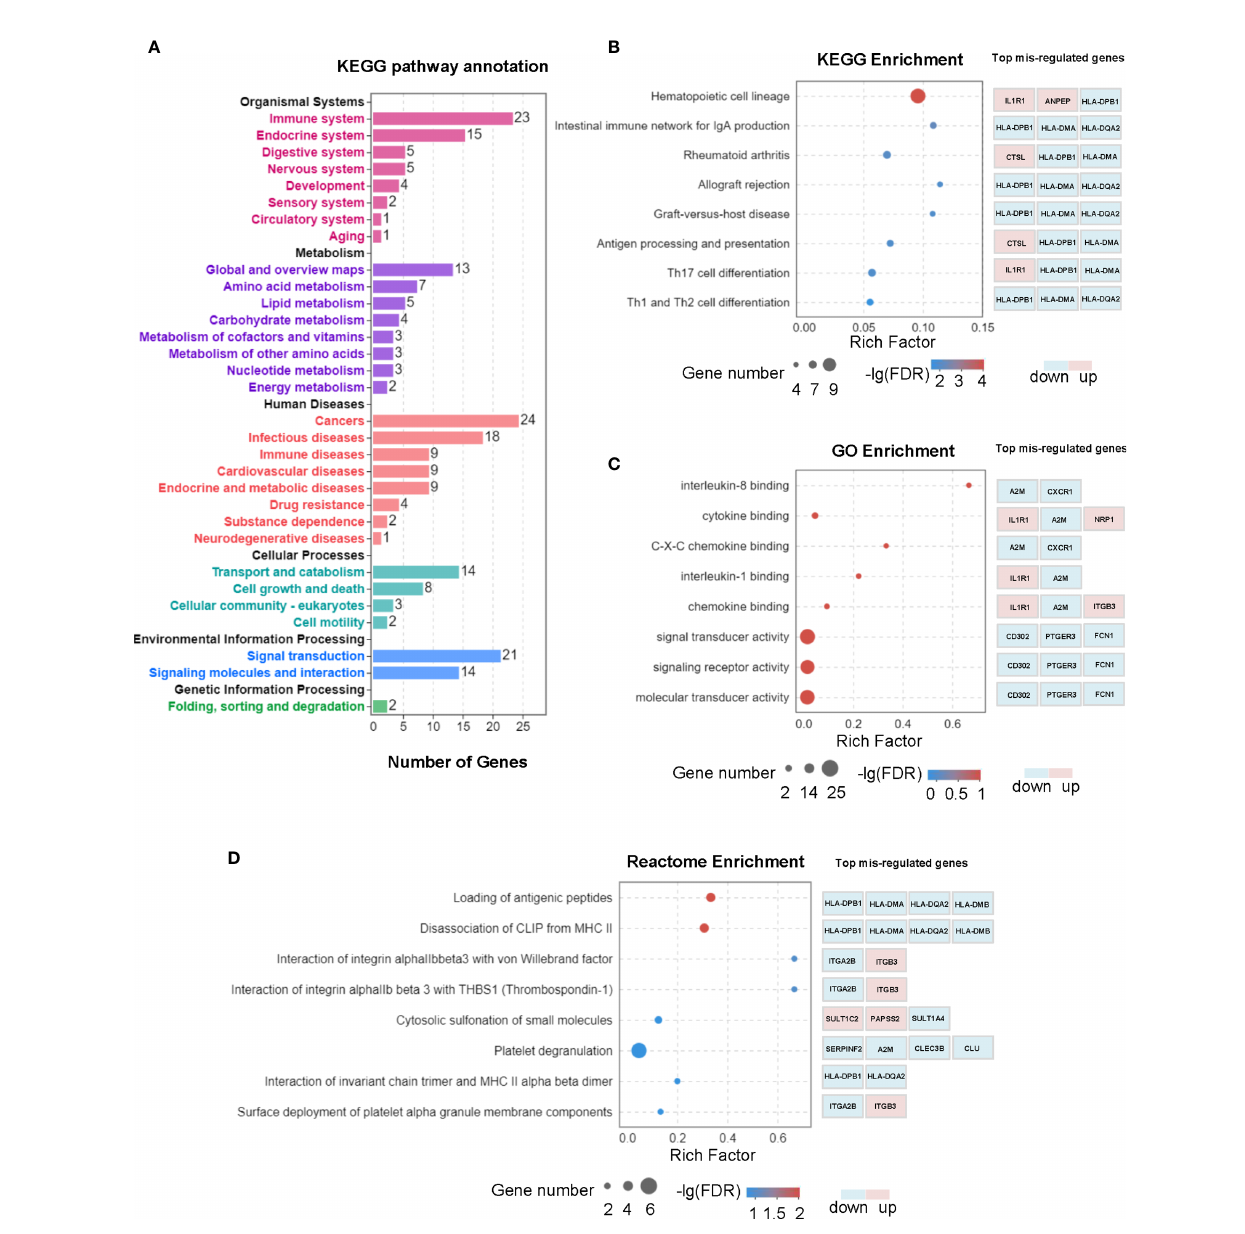
FIGURE 2 | Transcriptomic analysis revealed multiple changes in PBMCs after L-Cn stimulation. (A) KEGG analysis of genes enriched based on 168 differentially expressed genes with a fold change ≥ 2, and P < 0.05 showed changes in gene sets. (B) KEGG analysis was carried out to identify the top 20 differential pathway enrichment between L-Cn and the control group. (C) The top 20 statistics of GO terms of molecular function were plotted after L-Cn stimulation. (D) Reactome enrichment analysis identi fi ed the top 20 differential pathways. Rich factor refers to the ratio of the number of genes differentially expressed in the pathway entry to the total number of genes in the pathway entry. Eight of the top 20 differential pathways were